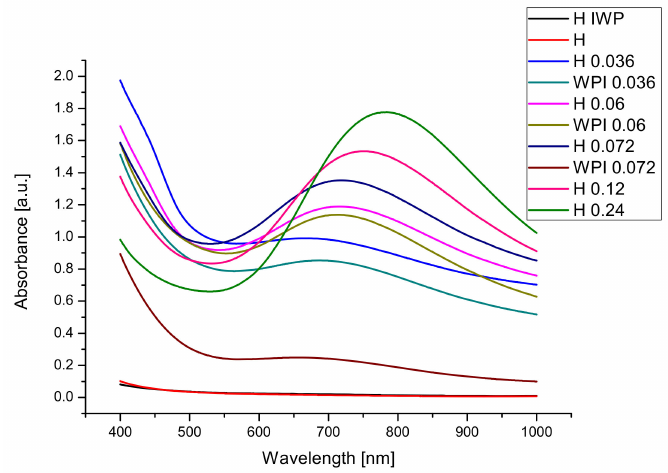
Figure 4. Optical properties of hydrogel